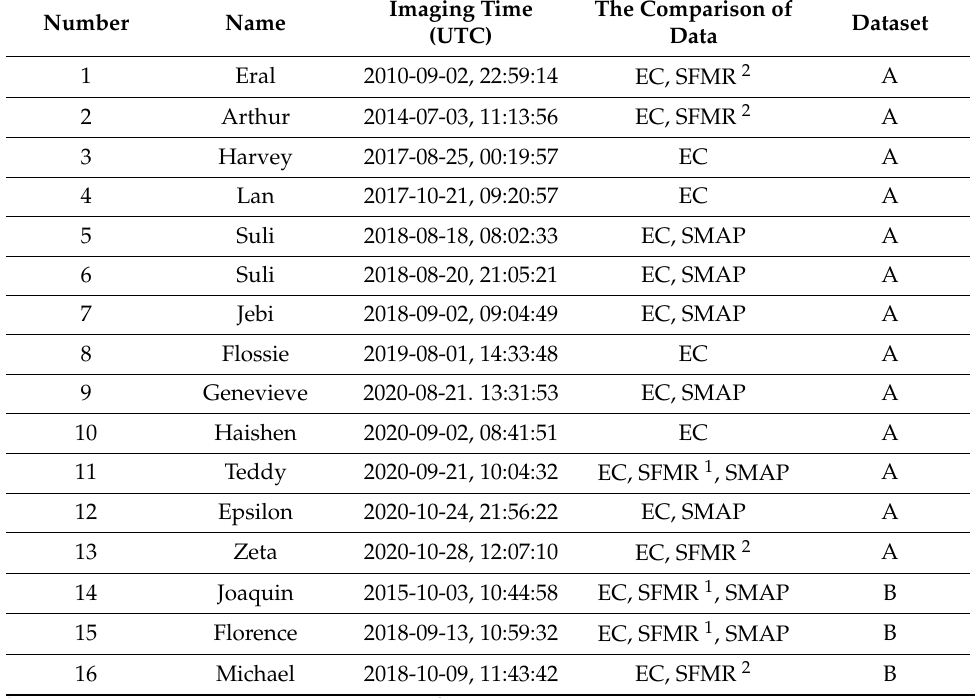
Table 1. Information of the RADARSAT-2 ScanSAR wide-mode